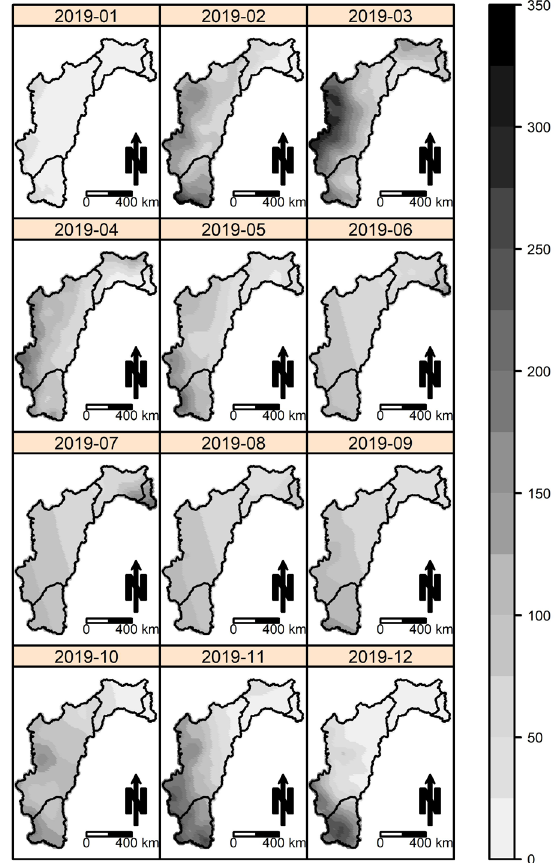
Figure 8. Maps of estimated precipitation in SFRB for all months of the year